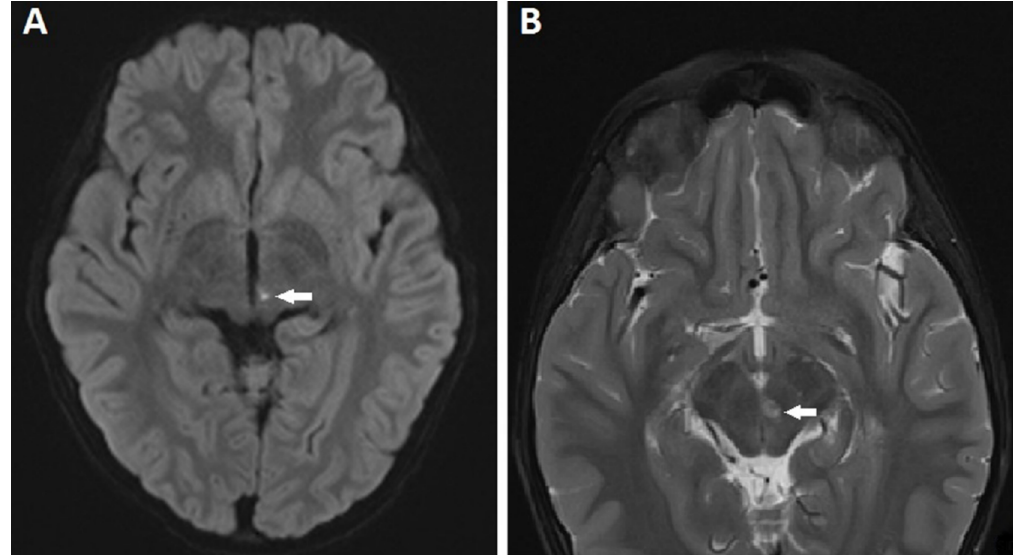
Figure 2: MRI scan of the brain showing tiny infarct (white arrow) in the left paramedian rostral upper midbrain at the level of the red nucleus; (A) axial diffusion weighted image showing restricted diffusion in the T2 hyperintensity, and (B) axial T2 fat saturated image showing T2 hyperintense focus